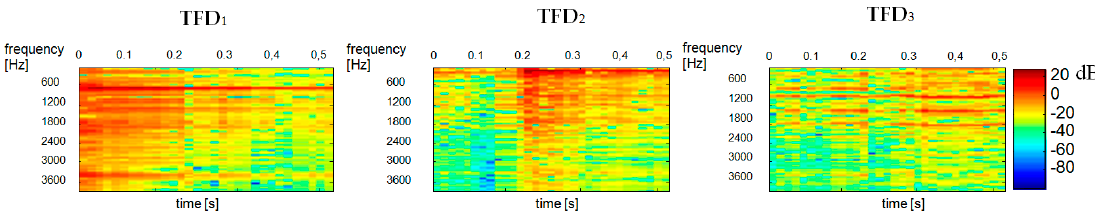
Figure 11. Statistically independent TFD i bases of a three-component signal for the variance α = 0.8.